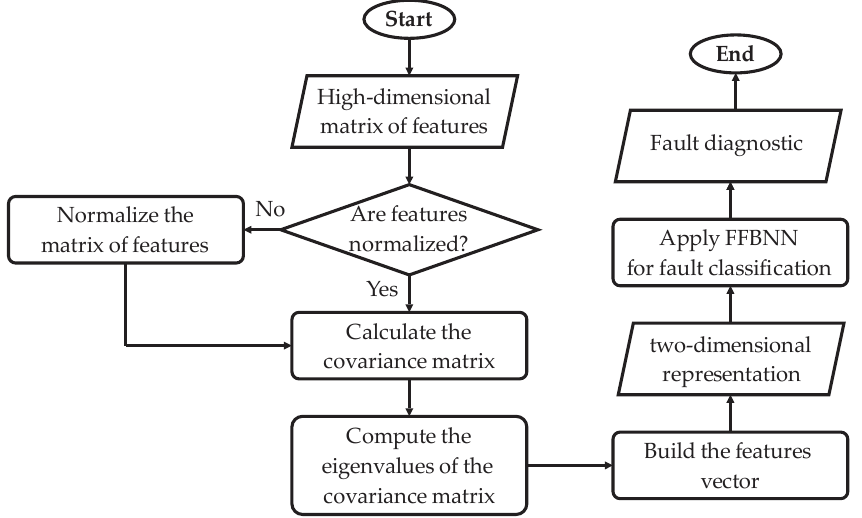
Figure 9. Flow diagram of the classification module implementation.